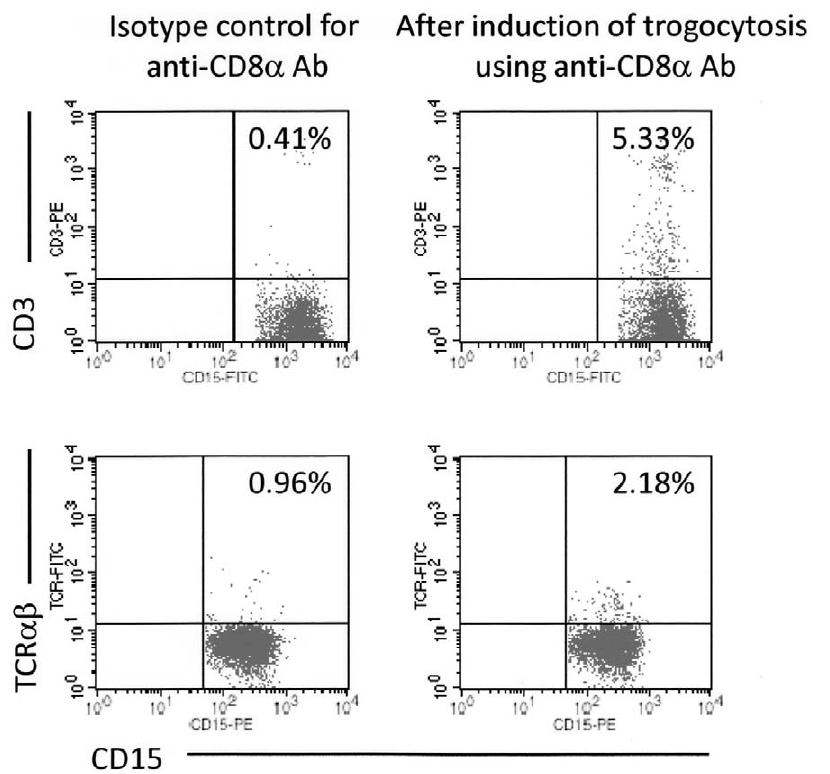
Figure 4. Bystander transfer of CD3 and TCR ab molecules accompanied by CD8 translocation from T cells to granulocytes. Heparinized blood samples were pre-incubated with the unlabeled anti-CD8 a Ab (HIT8a) or mouse IgG1, followed by depletion of erythrocytes, and then re-suspended in PBS. The cells were made to react with the PE-labeled anti-CD3 (UCHT-1) and FITC-labeled anti-CD15 (H198) Abs, or the FITC- labeled anti-TCR ab (WT31) and PE-labeled anti-CD15 (H198) Abs, followed by serving for FCM. PE or FITC-labeled mouse IgG1 and FITC or PE-labeled mouse IgM were used as isotype-matched controls for HIT8a and H198, respectively. These experiments were repeated 3 times.